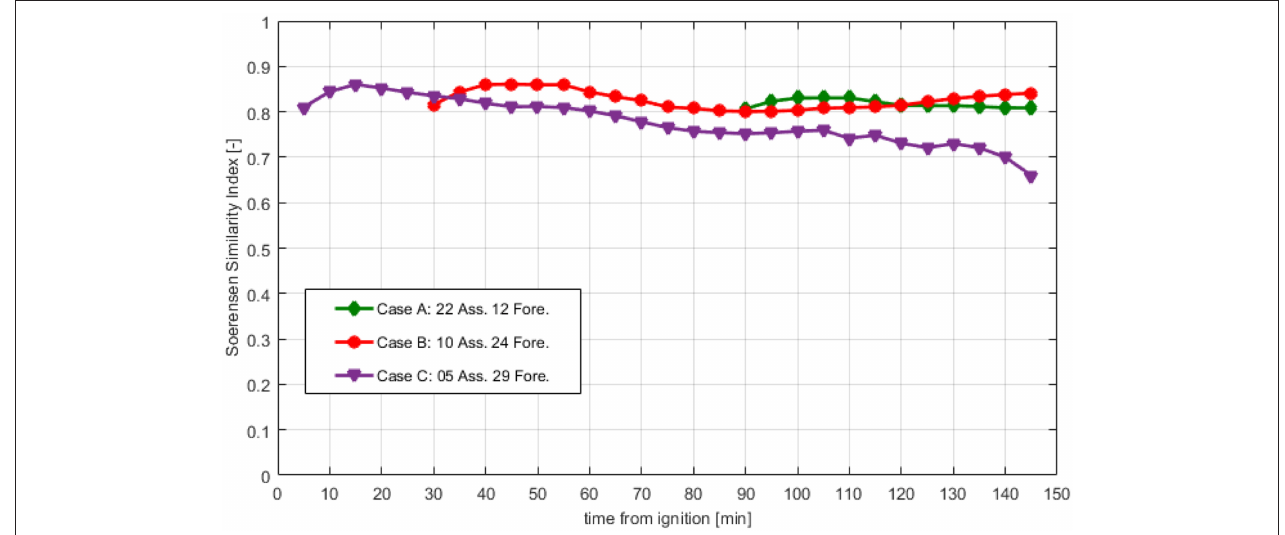
FIGURE 9 | Similarity index (SDIa) performance for all forecast fronts and the three different strategies explored. Ass, assimilated fronts; Fore, forecasted fronts.